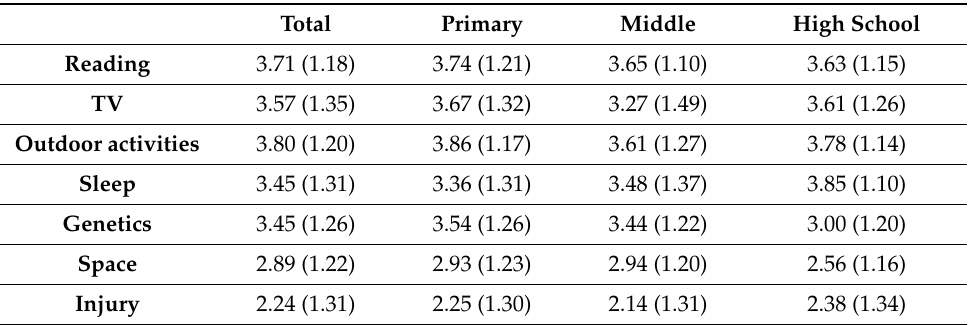
Table 3. Perceived causes of